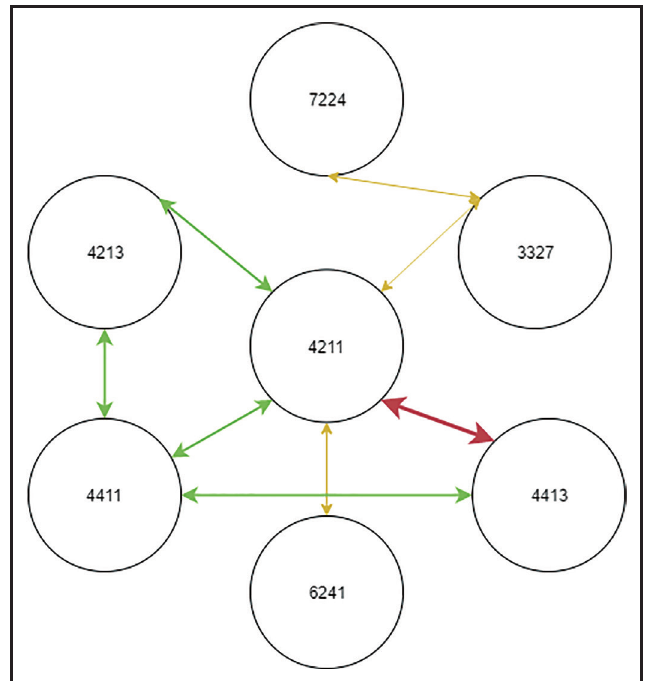
Figure 1 Creation of clusters of industries or labor